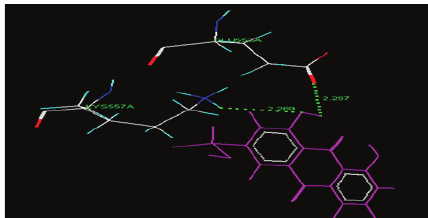
Figure 2: Hydrogen bond interaction of AE with protein 4COX.